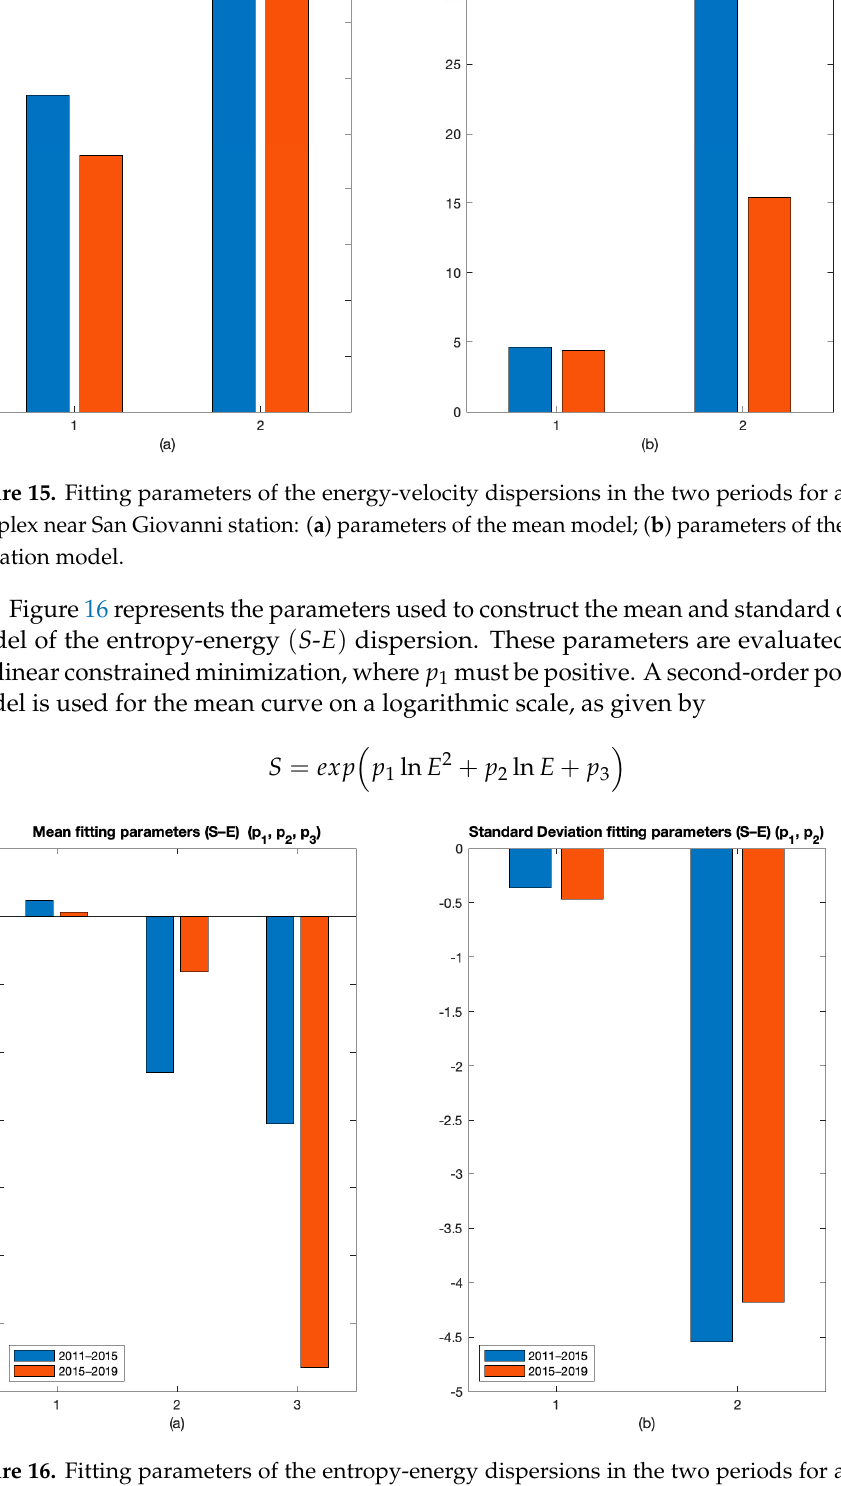
Figure 16. Fitting parameters of the entropy-energy dispersions in the two periods for a building complex near San Giovanni station: ( a ) parameters of the mean model; ( b ) parameters of the standard deviation model.